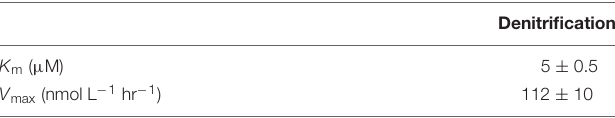
TABLE 2 | Michaelis–Menten parameters, K m ( µ M) and V max (nmol L − 1 hr − 1 ) for